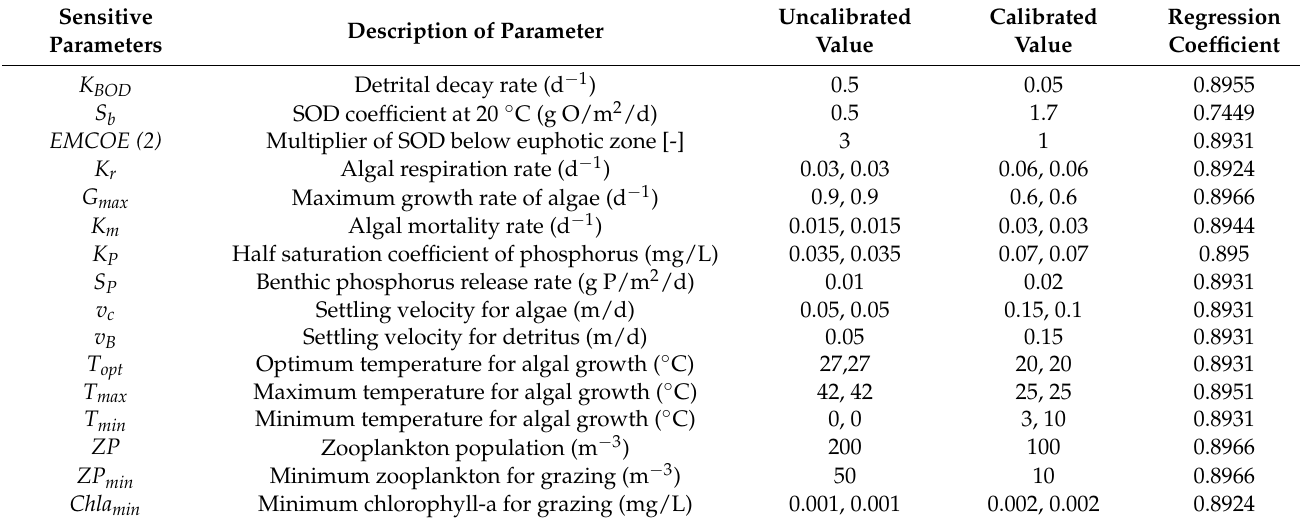
Table 4. Calibration parameters used in MINLAKE2020 for Lake Elmo with regression coefficients of the DO simulation.